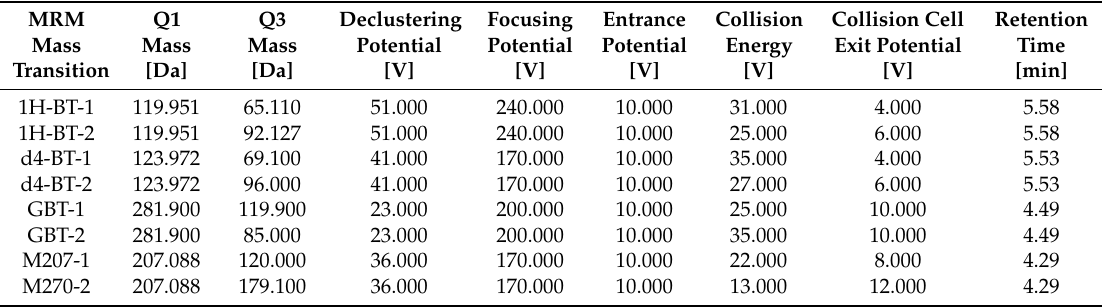
Table A1. HPLC-MS/MS parameters for BT and BT